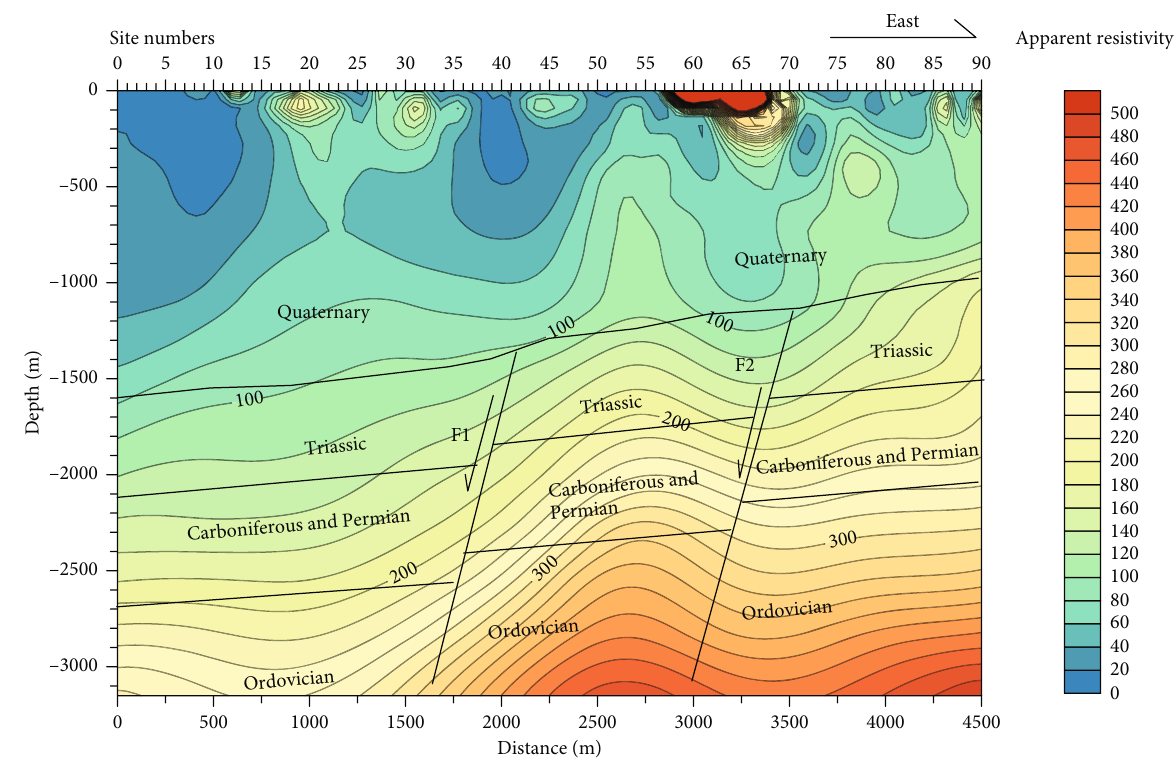
Figure 11: Resistivity characteristics of normal